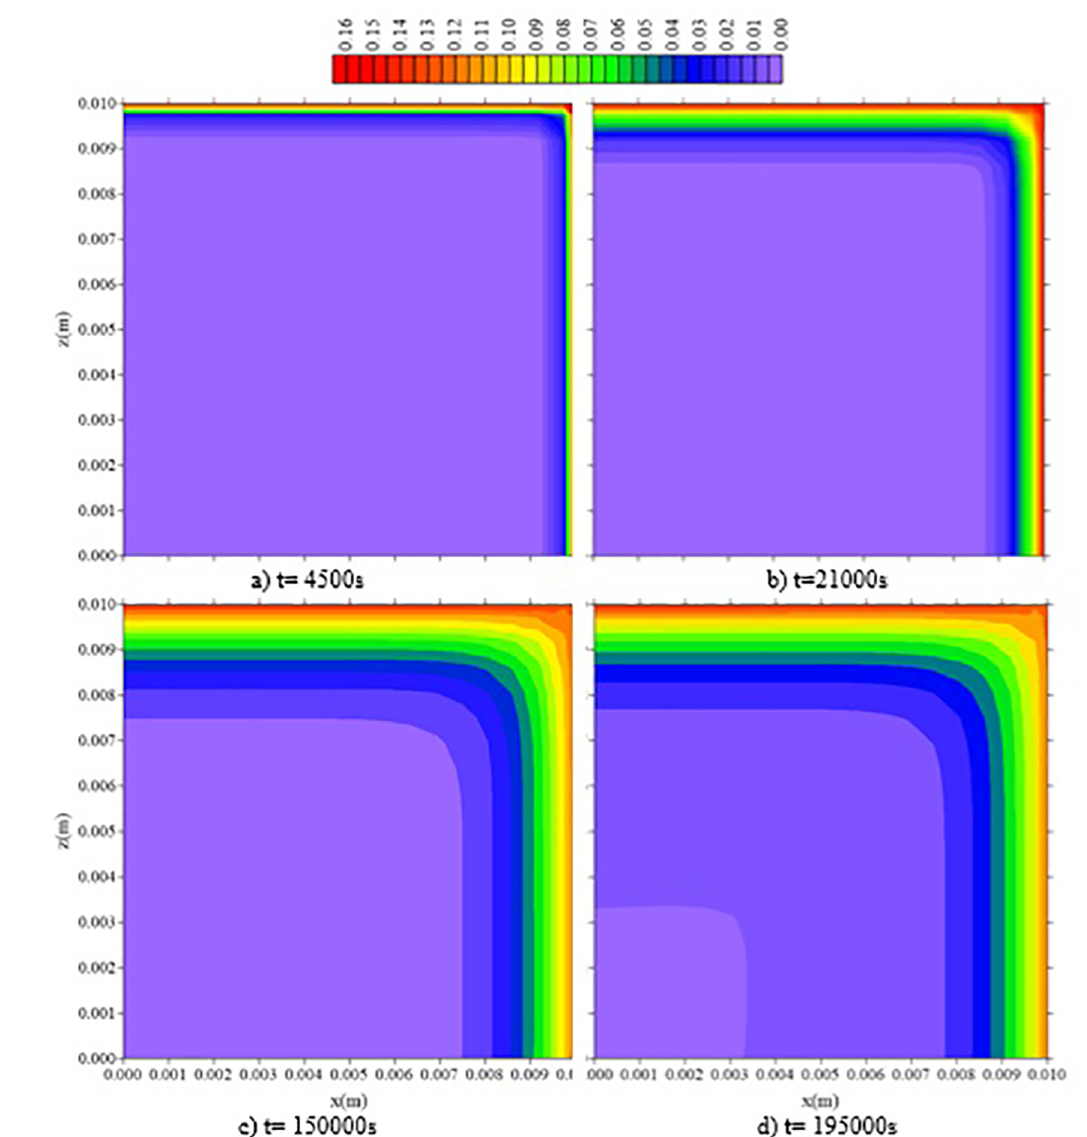
/2 plane for different water absorption y